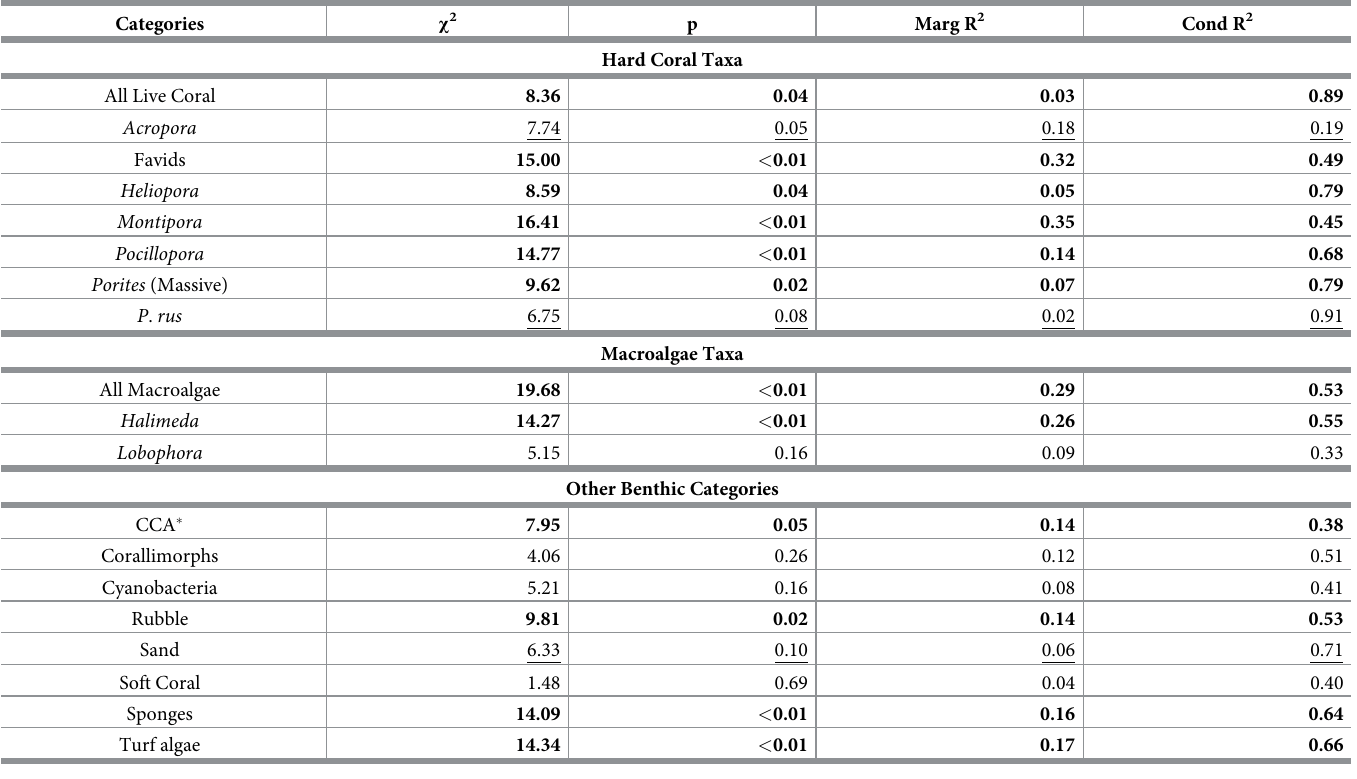
Table 2. Results of linear mixed effects models for each key benthic category. Statistically significant results at α = 0.05 are in bold, while those that are significant at α = 0.10 are underlined.